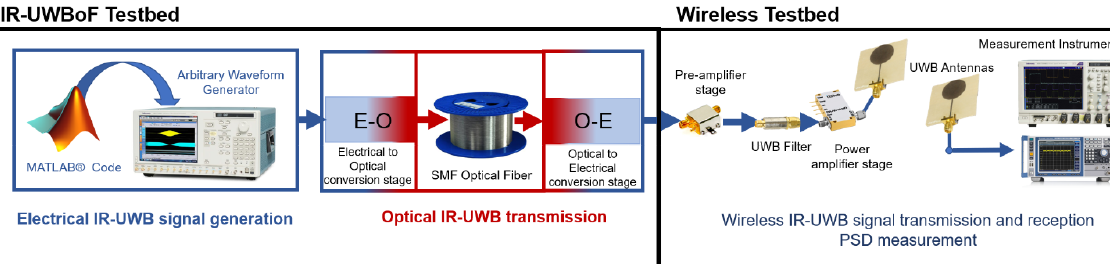
Figure 1. Optical-Wireless IR-UWBoF testbed.